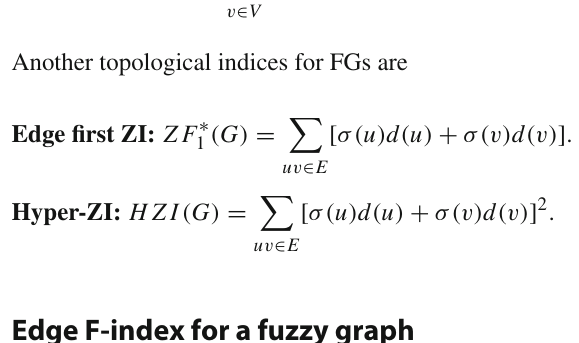
vertex-degree co-ordinate of u v from origin. Hence, edge F-index is sum of such square of the